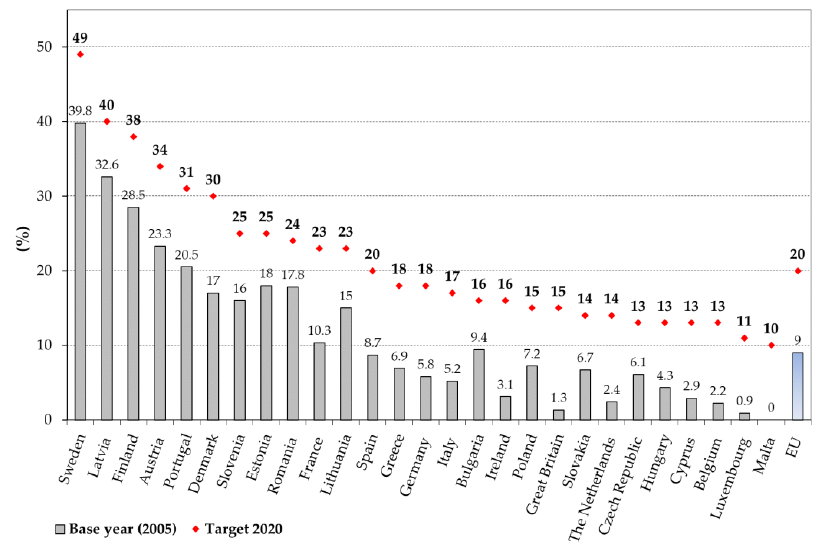
Figure 1. 2020′s targets and share of renewable energy generation in the base year 2005